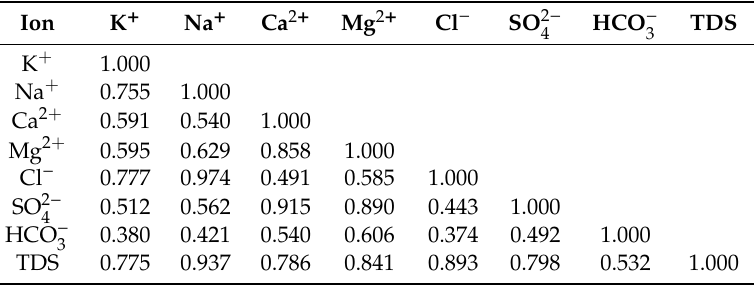
Table 2. Correlation matrix for all water samples (n =